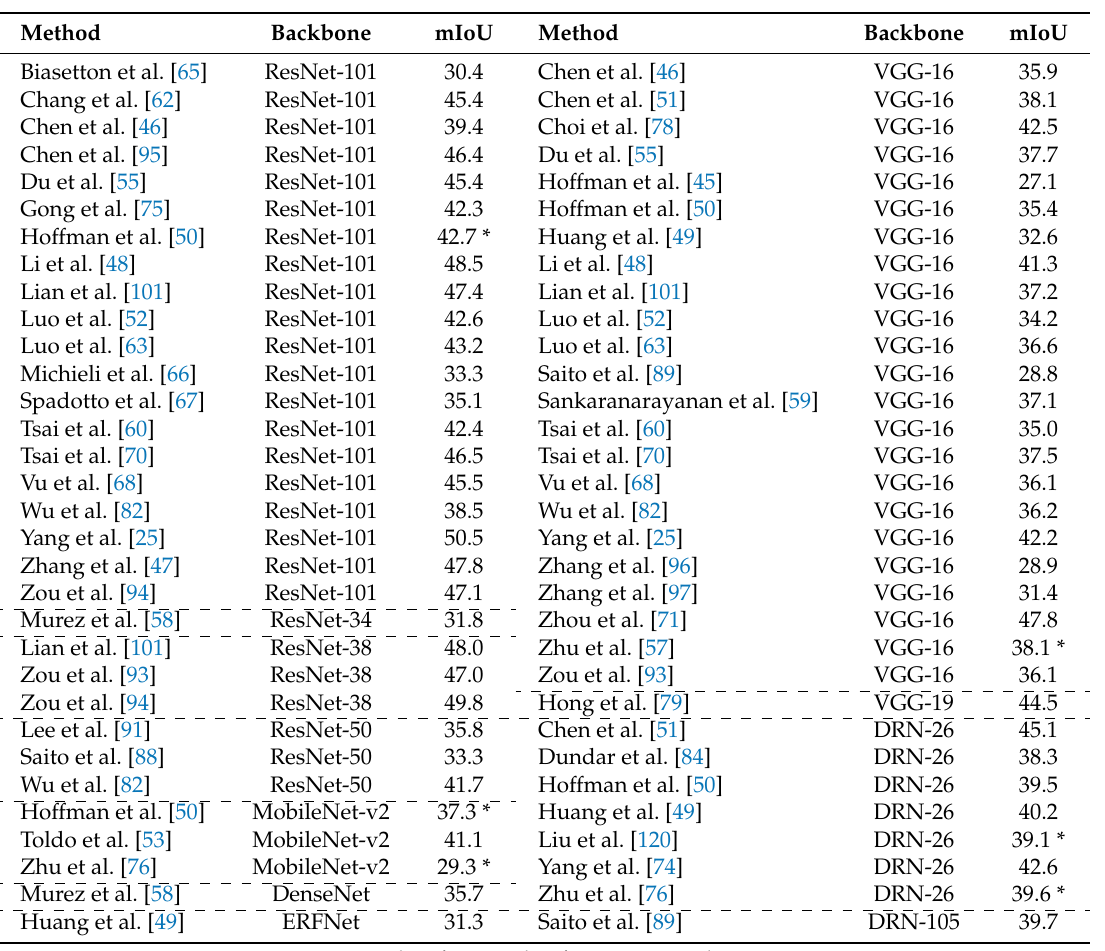
Table 1. Mean IoU (mIoU) for different methods grouped by backbone in the scenario adapting source knowledge from GTA5 to